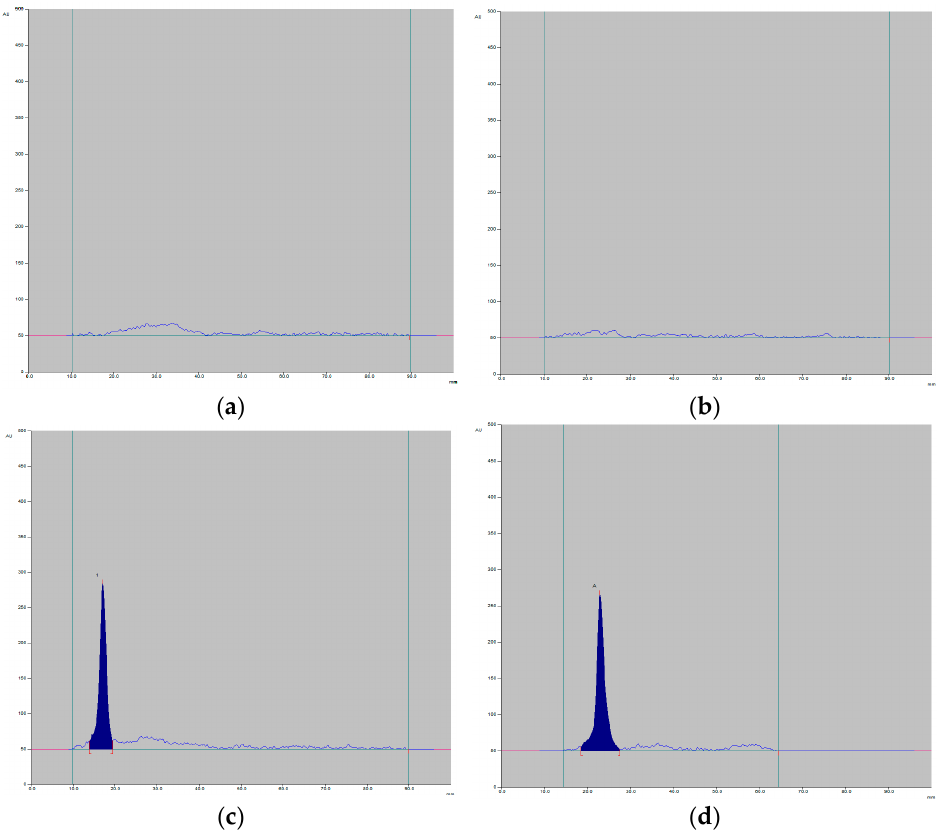
Figure 4. An example of densitograms recorded for baseline (blood ( a ) and urine ( b )) and ceftobiprole (extracted from blood ( c ) and urine ( d )).